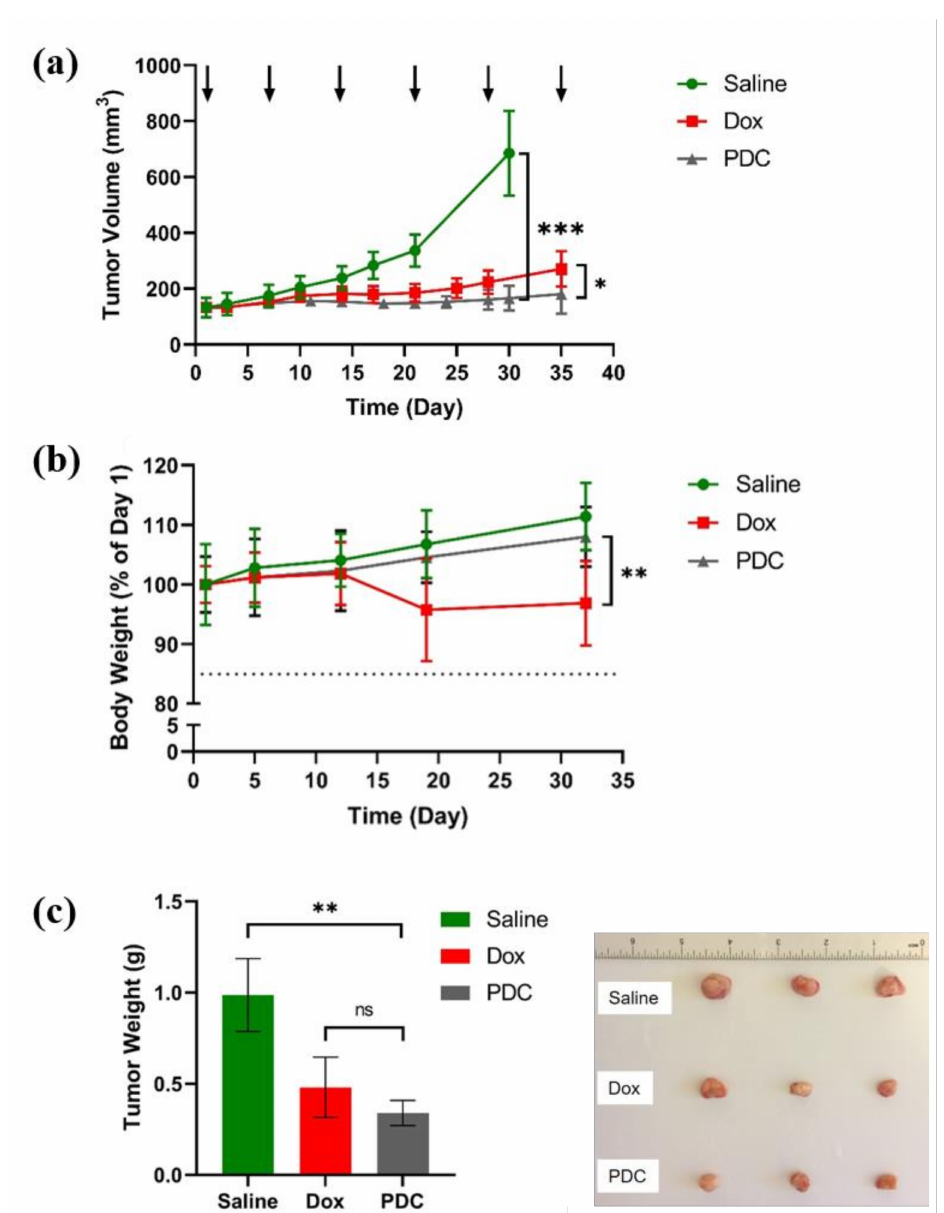
Figure 4. Effects of PDC on tumor growth using a mouse model of TNBC. NOD-SCID female mice bearing xenograft human MDA-MB-231 tumors were treated with PDC (2.5 mg Dox equiv./kg), Dox (2.5 mg/kg), or saline (0.9% normal saline). ( a ) Tumor volumes measured over the duration of treatment. The treatment regimen included six tail-vein injections administered weekly (as indicated by arrows). Results are presented as mean ± SD; n = 7; * p < 0.05, *** p < 0.001, Student t -test and one-way ANOVA test (at day 30 or day 35); ( b ) Average body weight of mice for each treatment group. Results are presented as mean ± SD; n = 7; ** p < 0.01, Student t -test and one-way ANOVA test (at day 32); ( c ) average tumor weight after mice were euthanized and tumors collected. Results are presented as mean ± SD; n = 7; ** p < 0.01, ns non-significant, Student t -test and one-way ANOVA test. (RHS of c) representative images of the tumor xenografts collected from three